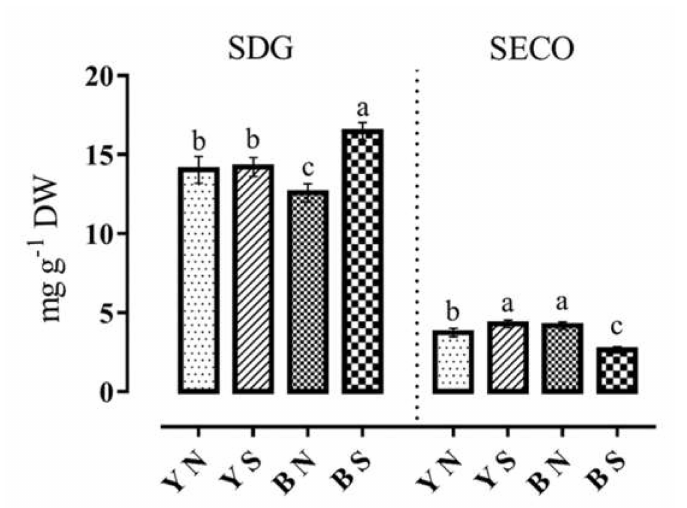
Figure 3. Diagrams of SDG content (secoisolariciresinol diglucoside, in mg g − 1 dry weight) and SECO content (Secoisolariciresinol, in mg g − 1 dry weight) extracted from families of flax under water stress and normal irrigation conditions. A same letter above columns for each trait (diagram) indicates that values are not statistically different ( p > 0.05). Values are mean ± standard error. Letters Y, B, N, and S denote yellow color, brown color, normal conditions, and water stress conditions,